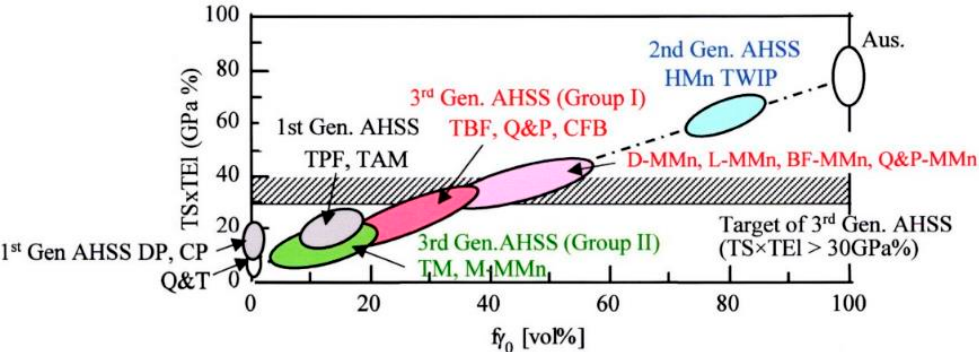
Figure 1. Relationship between the product of tensile strength and total elongation (TS × TEl) and an initial volume fraction for retained austenite, reverted austenite, or austenite ( f γ 0 ) in the first-, second-, and third-generation (Group I and Group II) advanced high-strength steel (AHSS) sheets. Q&T: quenching and tempering martensitic steel, DP: dual-phase steel, CP: complex-phase steel, TPF, TAM, TBF, and TM: transformation-induced plasticity (TRIP)-aided steels with polygonal ferrite, annealed martensite, bainitic ferrite, and martensite matrix structure, respectively. Q&P: one-step and two-step quenching and partitioning steels, CFB: carbide-free bainitic steel, D-MMn: duplex type medium-Mn steel, L-MMn: laminate type medium-Mn steel, BF-MMn: bainitic ferrite-type medium-Mn steel, Q&P-MMn: Q&P-type medium-Mn steel, M-MMn: martensite-type medium-Mn steel, HMn TWIP: high-manganese TWIP steel, Aus: austenitic steel. This figure is reproduced based